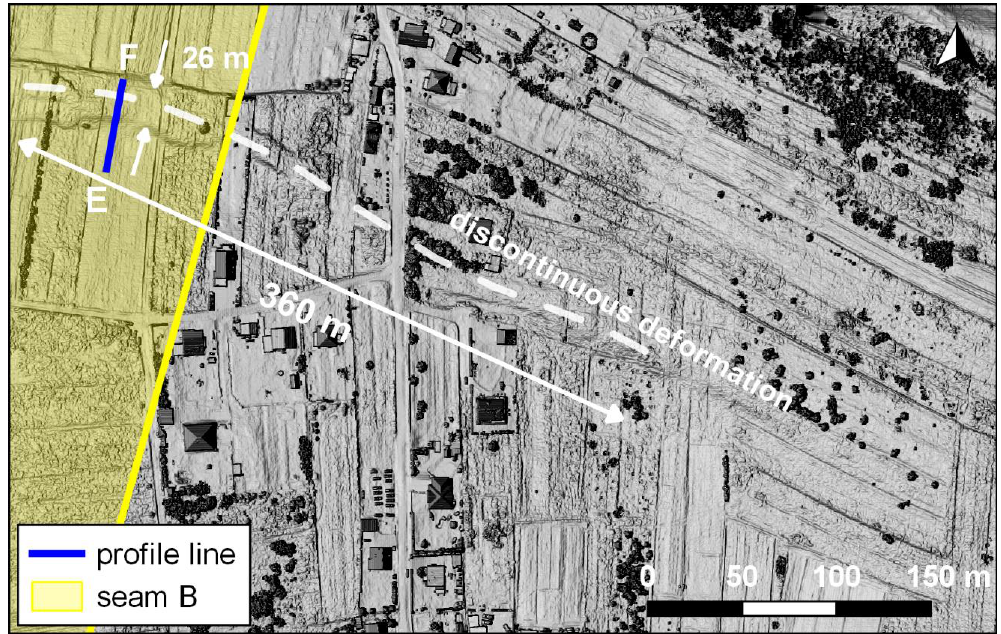
Figure 11. A discontinuous deformation identified at the Jaworzno site using 02.2020 series data collected via UAV.